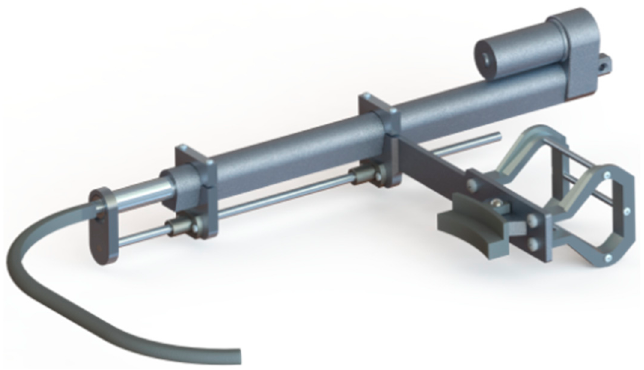
Figure 6. Pole-climber. Figure 6.